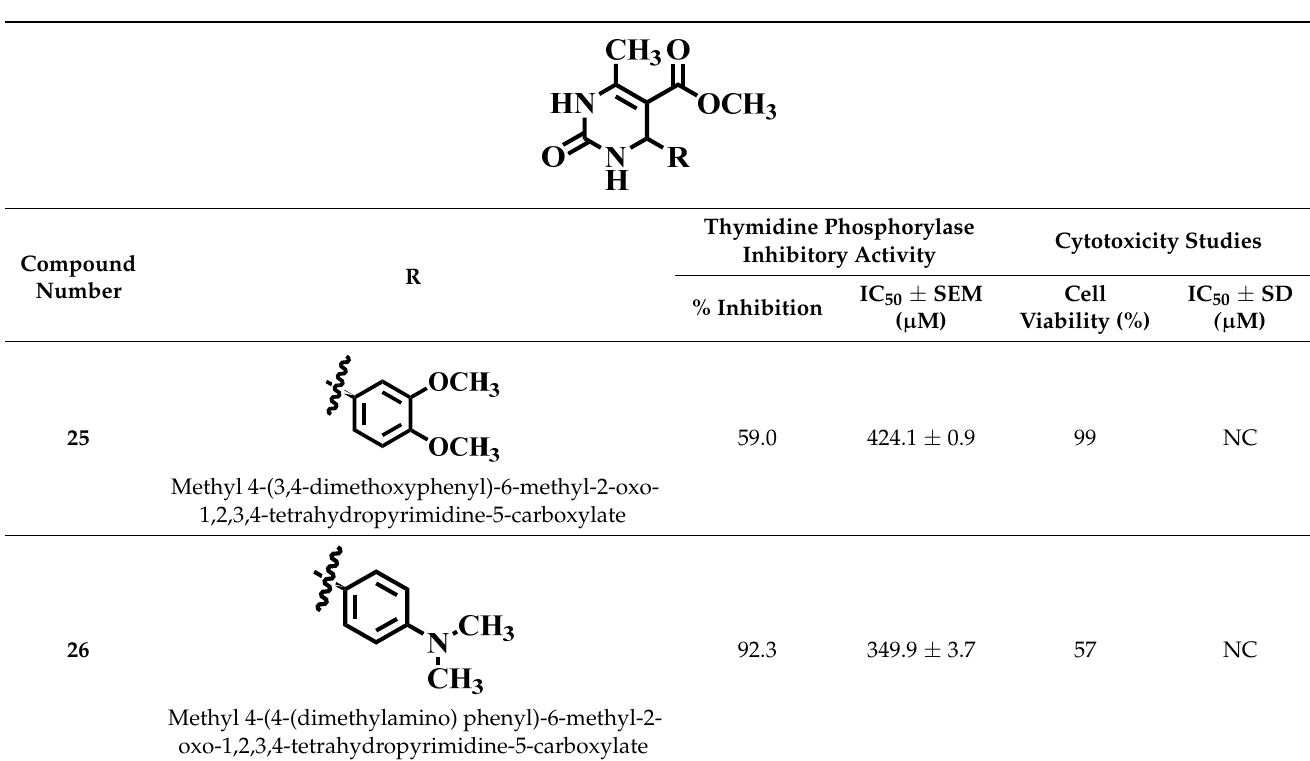
Table 1. Thymidine phosphorylase (TP) inhibitory activity of dihydropyrimidone ( 1 – 40 Table 1. Cont.